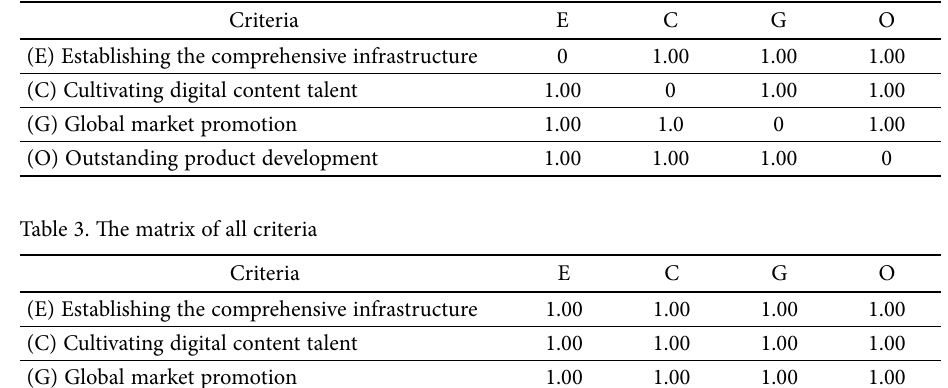
Table 2. The interrelation matrix